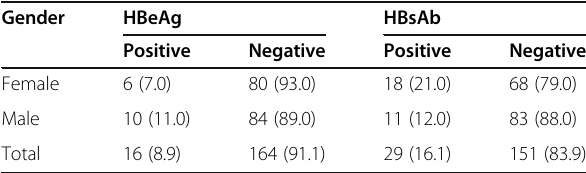
Table 3 Hepatitis Be antigen and hepatitis surface antibody positivity and gender among hepatitis B surface antigen- positive patients